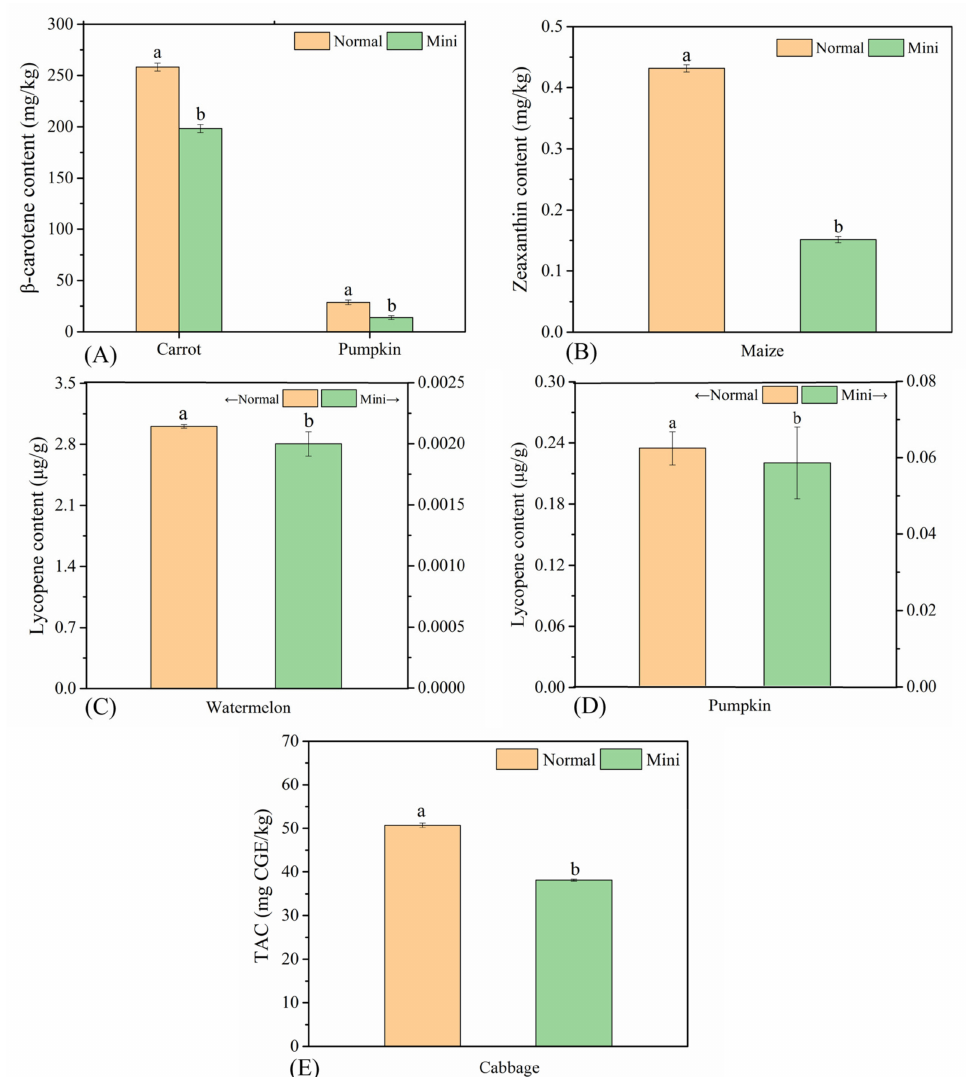
Figure 3. The characteristic nutrient contents of MFV and NFV: ( A ) β -carotene content of carrots and pumpkins; ( B ) zeaxanthin content of maize; ( C ) lycopene content of watermelon; ( D ) lycopene content of pumpkin; ( E ) anthocyanin content of cabbage. Values with different letters are significantly different ( p < 0.05) from each